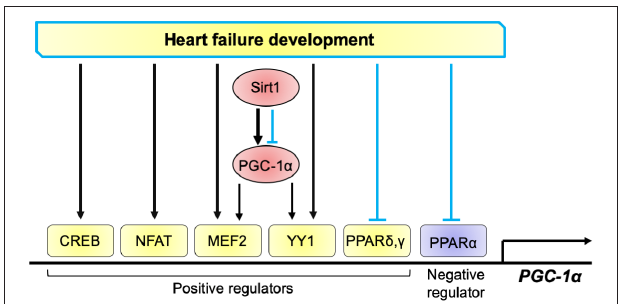
FIGURE 2 | Transcriptional regulation of PGC-1 α in the heart. Positive regulators for PGC-1 α transcription include CREB, NFAT, MEF2, YY1, PPAR δ , and PPAR γ , whereas those negatively regulate PGC-1 α include PPAR α . These factors are activated (black arrows) or inhibited (blue lines) in the progression of heart failure. PGC-1 α promotes its transcription through co-activation of MEF2 and YY1. Sirt1 either activates and inhibits PGC-1 α , thereby positively and negatively regulates PGC-1 α